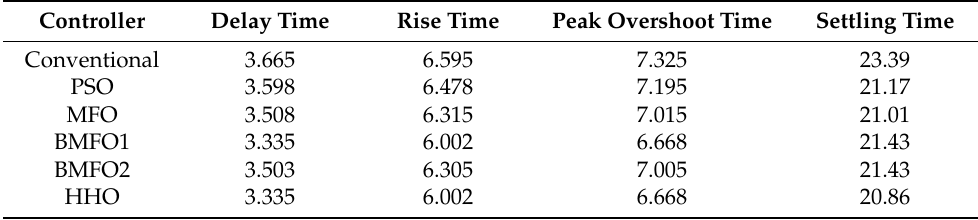
Table 7. Graph analysis of GENCOs generation response of Area1 with various controllers under unilateral